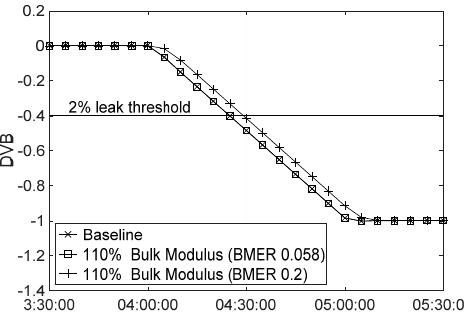
Figure 6. Effect of bulk modulus error on leak detectability with exact and excessive BMER in a system with R = 2.20 with perfect data.